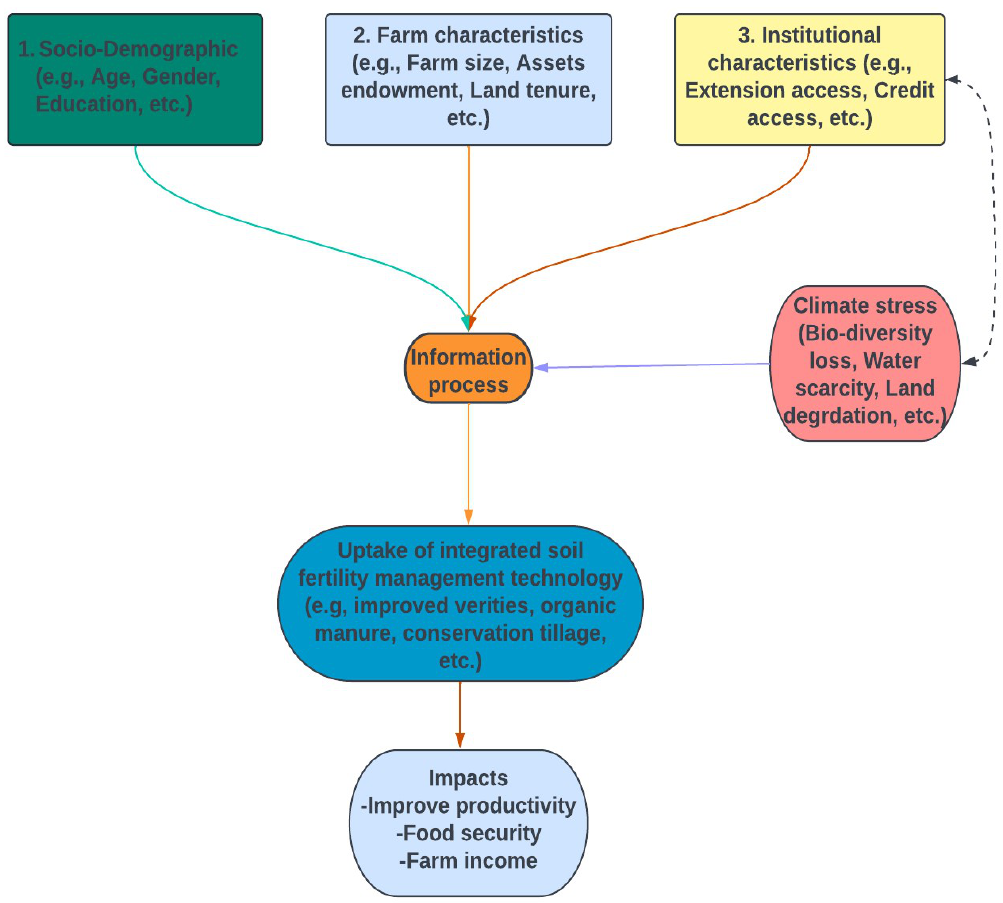
Figure 1. The conceptual framework for the study.